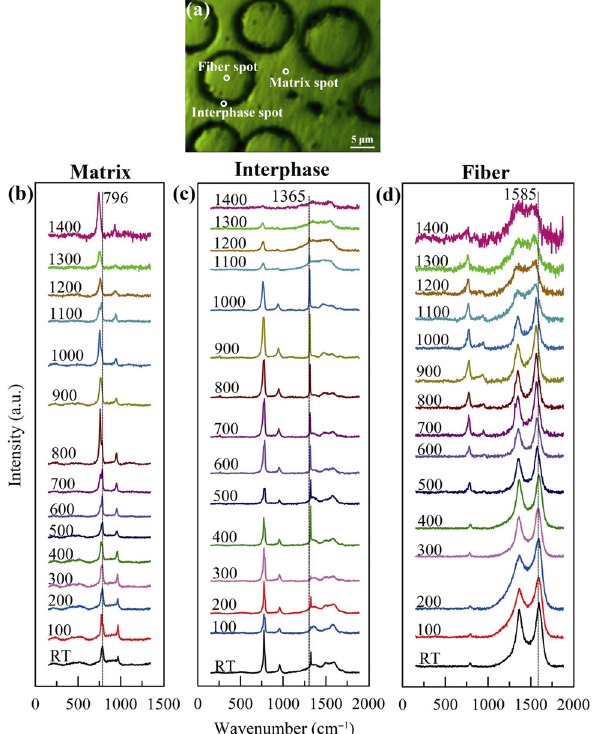
Fig. 3 (a) Selected spots for Raman spectrum detection and (b–d) corresponding Raman spectra at room temperature to 1400 ℃ .